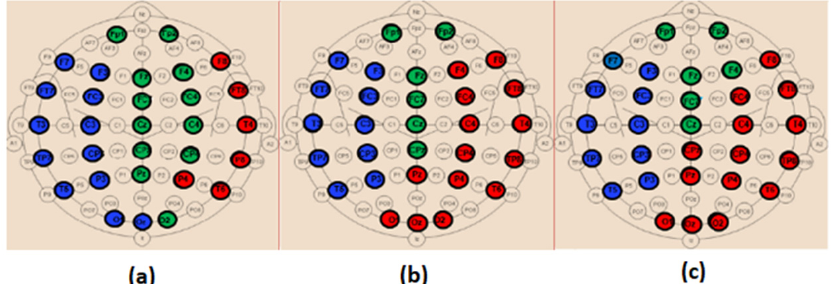
Figure 13. The distribution of the nodes in each module in the alpha band for the ( a ) SCI, ( b ) MCI and ( c ) AD groups.